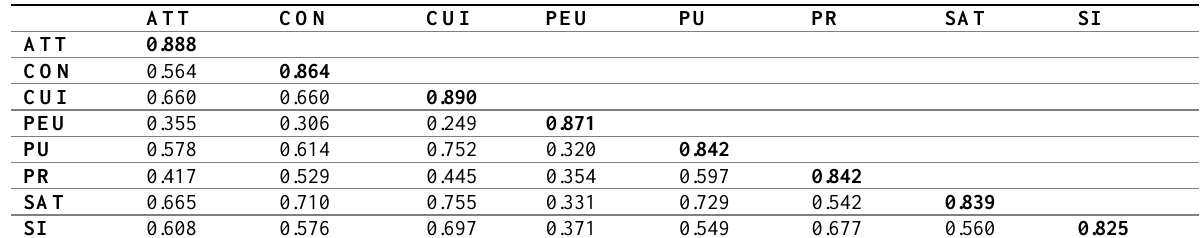
Table 3: Correlation Matrix and the square root of the AVE